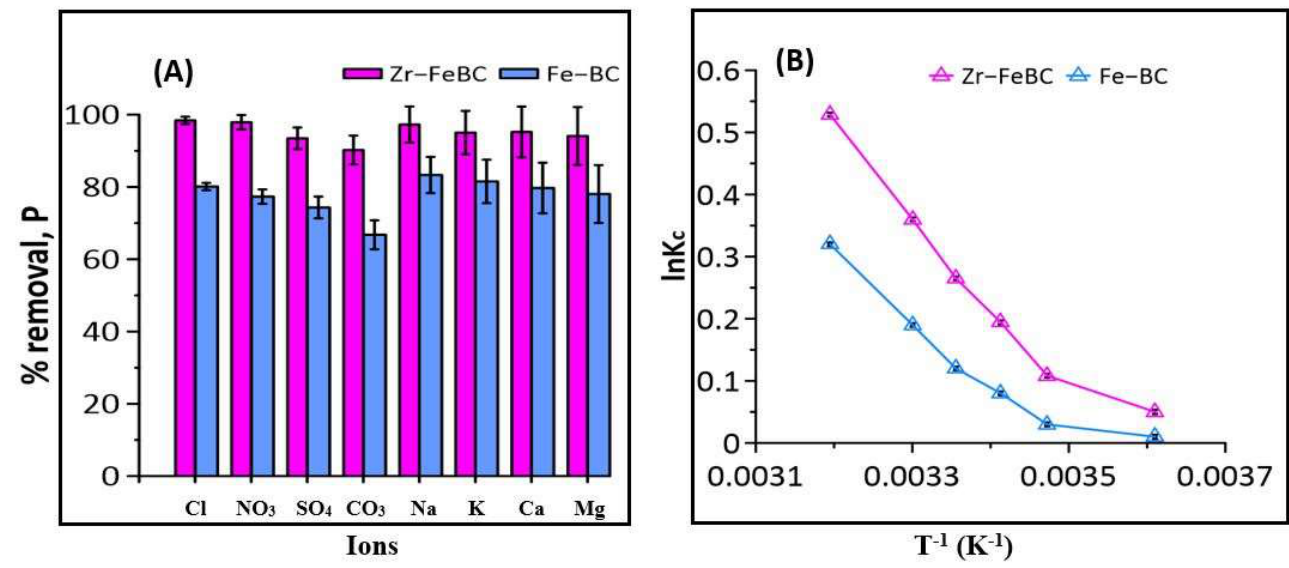
Figure 5. Effect of co-existing ions on P removal ( A ), and temperature ( B ) by Zr–FeBC and Fe–BC (initial P concentration was 20 mg L –1 and biochar concentration was 2.0 g L –1 ).